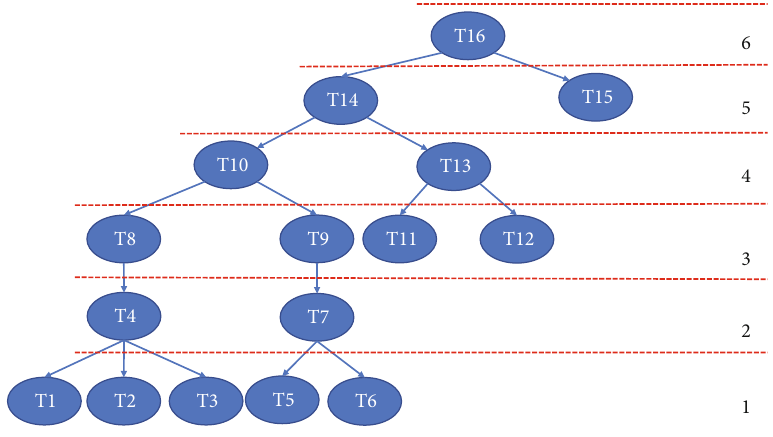
Figure 4: Task correlation level tree.